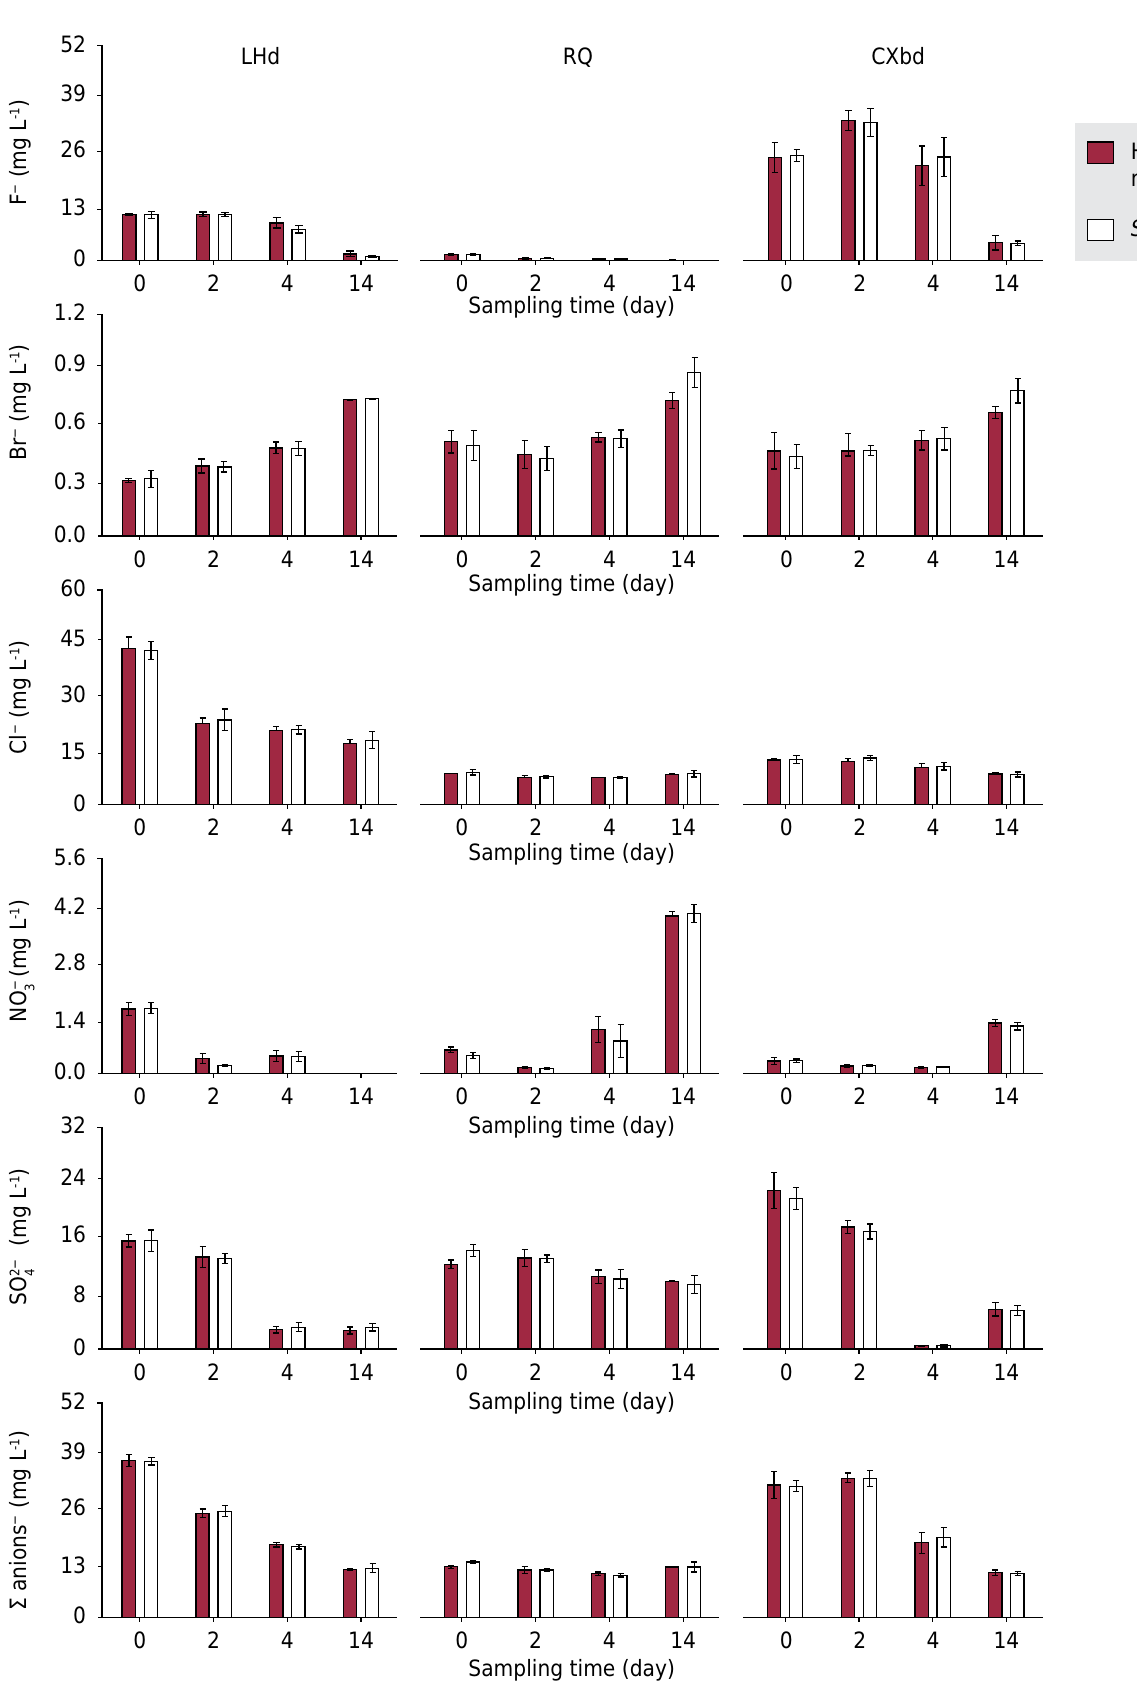
Figure 2. Anion concentrations in the soil solutions sampled by the Suolo Acqua and hydrophilic membrane (HM) at four sampling times. F − = fluoride; Cl − = cloride; NO − 3 = nitrate; Br − = bromide; SO 4 2− = sulfate. LHd - Latossolo Húmico Distrófico , RQ - Neossolo Quartzarênico and CXbd - Cambissolo Háplico Tb Distrófico